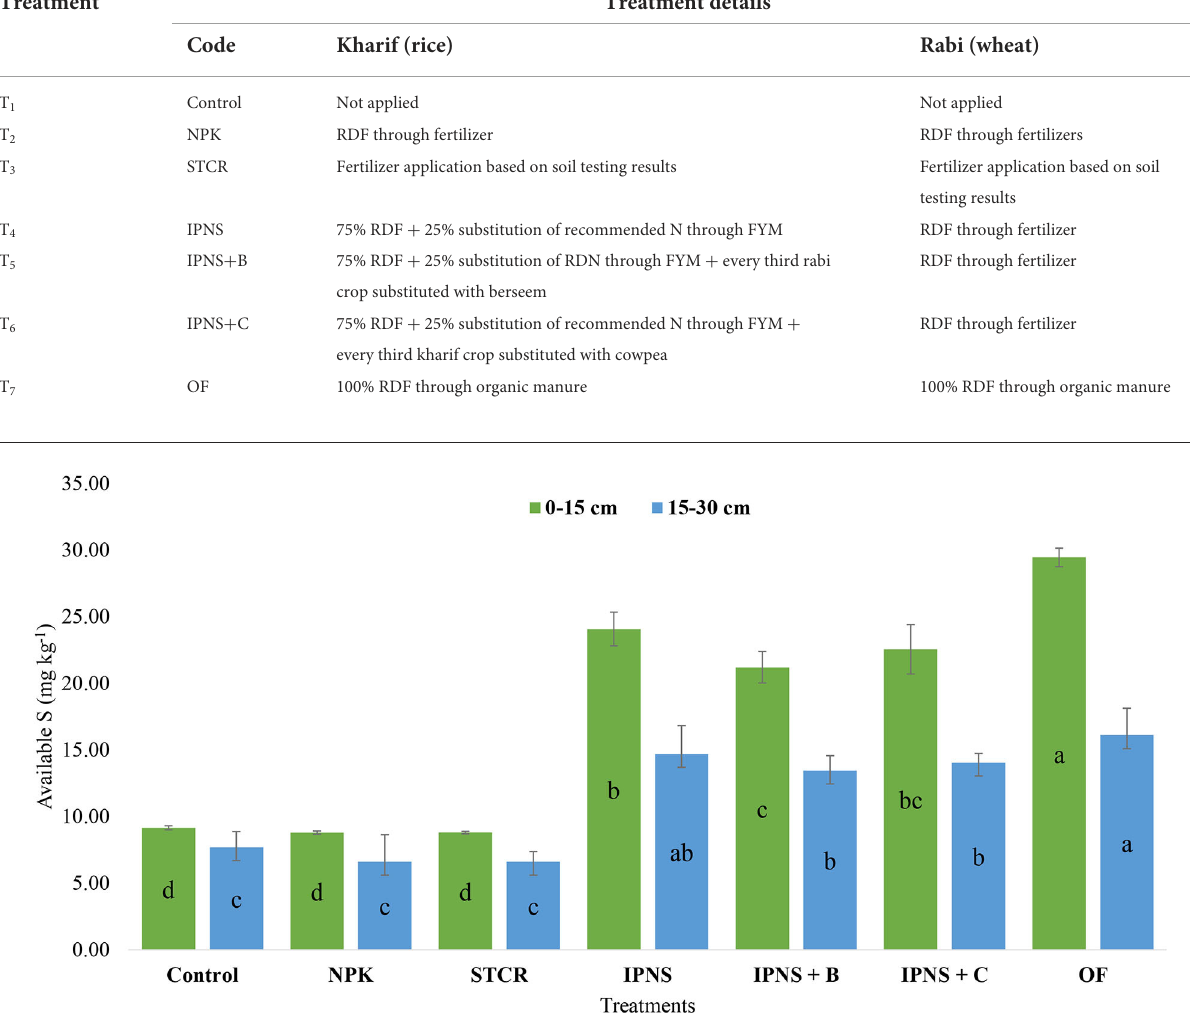
TABLE 1 Experimental setup and treatments details for different nutrient supply options.